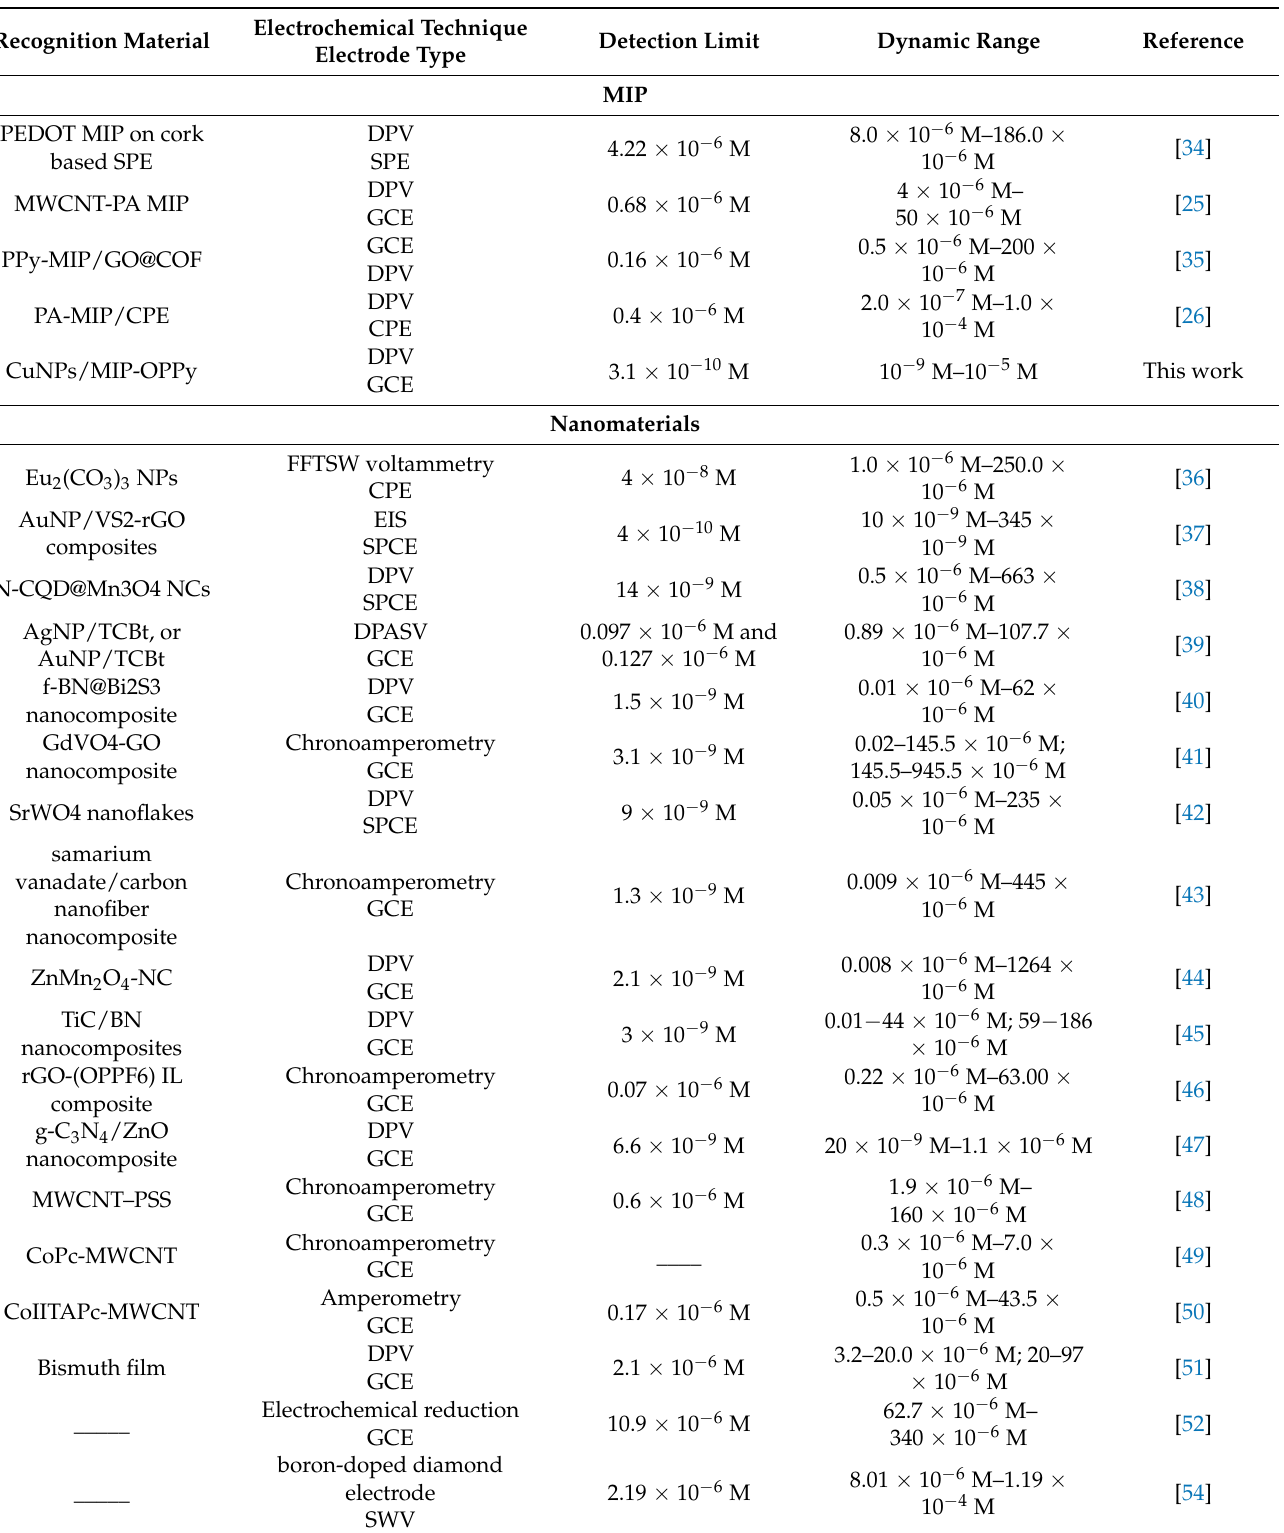
Table 2. Analytical performance of previously published electrochemical sensors for SDZ